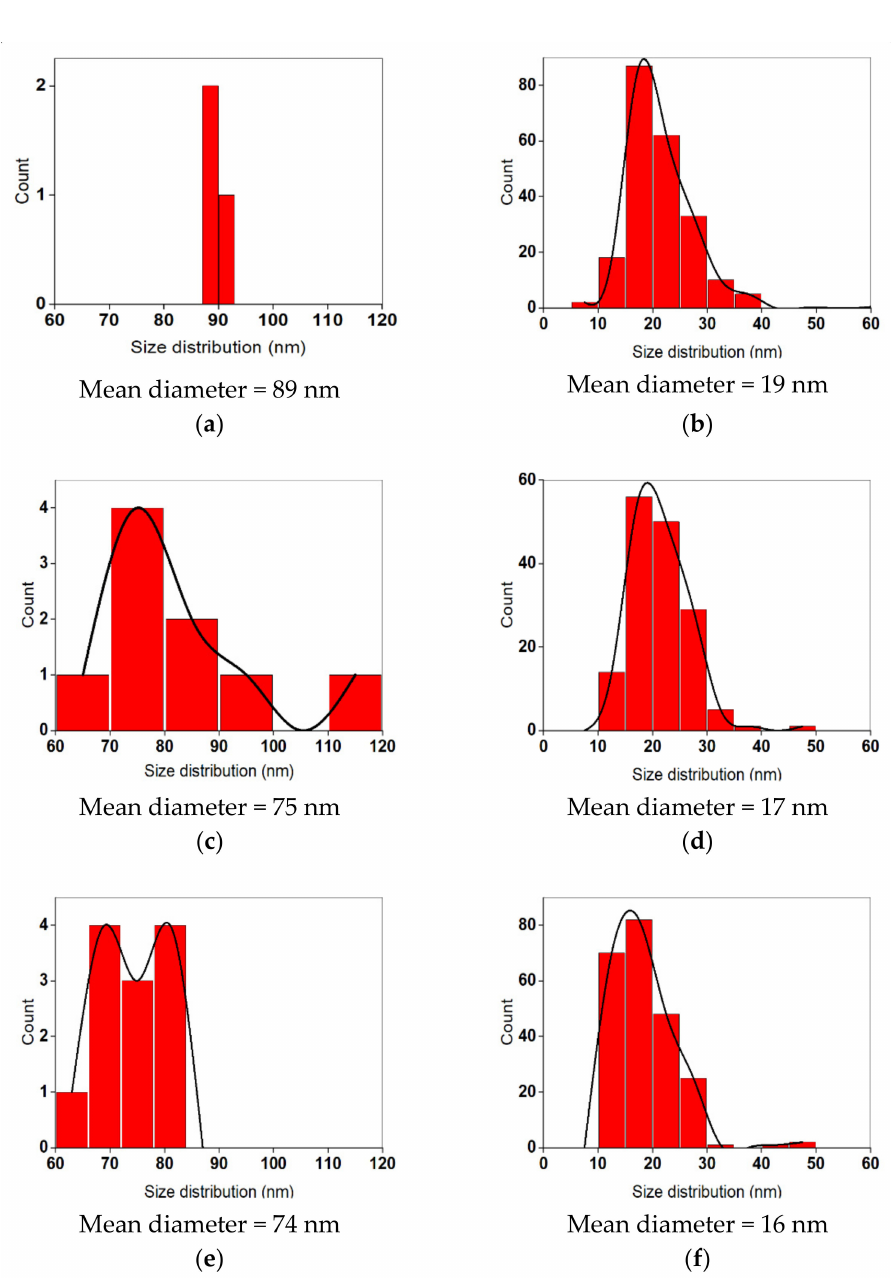
Figure A1. Size distribution histograms for the determination of average diameters (D1 and D2) of AgNPs prepared at different spin-coating speeds: ( a , b ) 3000; ( c , d ) 5000; and ( e , f ) 7000